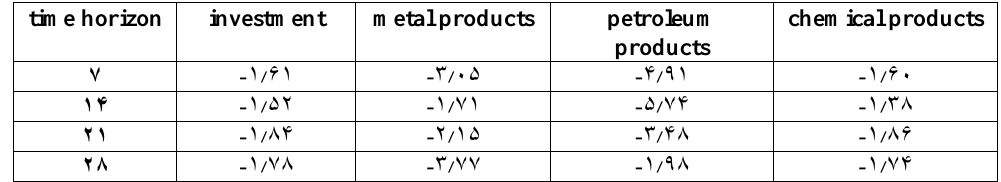
Table 15. Predicting the non-regime VaR of indices for the designated industries in the